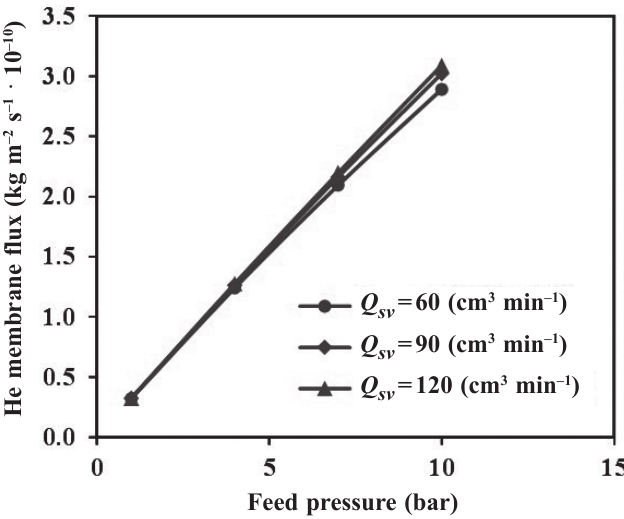
Fig. 6 – Impact of feed pressure on CH different feed flow rate